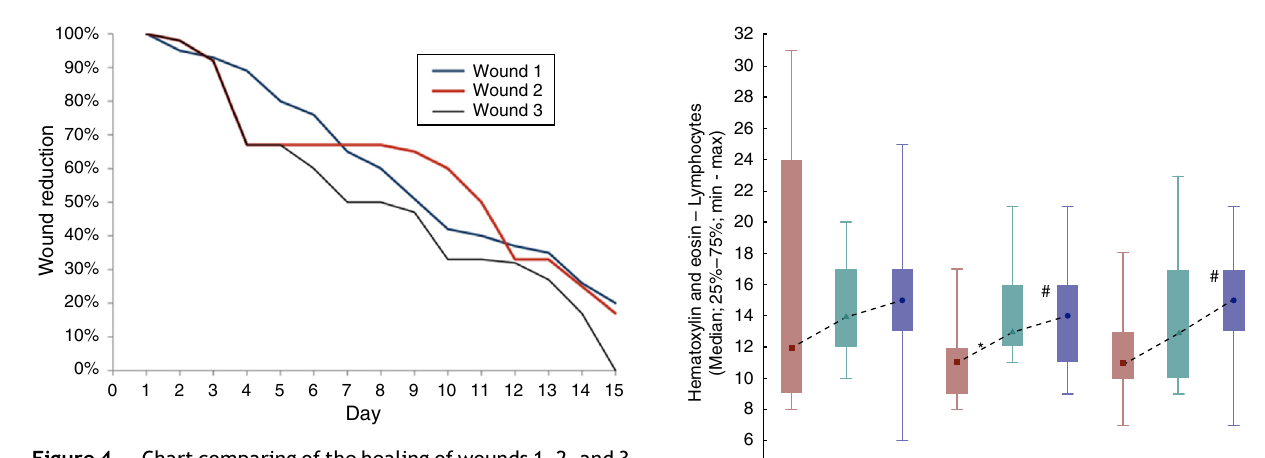
the wound diameter; in F2, the reduction was 83% ± 0.201%, and in F3 it was 100% (Fig. 4). When comparing the three types of wound on each day of the animals’ euthanization, there were no significant dif- ferences in the number of neutrophils (Table 1). However, when evaluating the progress of each wound on the three days of the animals’ euthanization, a significant difference was found for F1, which showed the highest number of neu- trophils. For this wound, there were differences between the third and seventh days ( p = 0.029) and between the sev- enth and 15th days ( p = 0.007). Between the third and 15th days there was no significant difference ( p = 0.557). For F2 and F3, the results were lower, with a tendency to signif- icance among the three days of assessment ( p = 0.058 and p = 0.076, respectively).